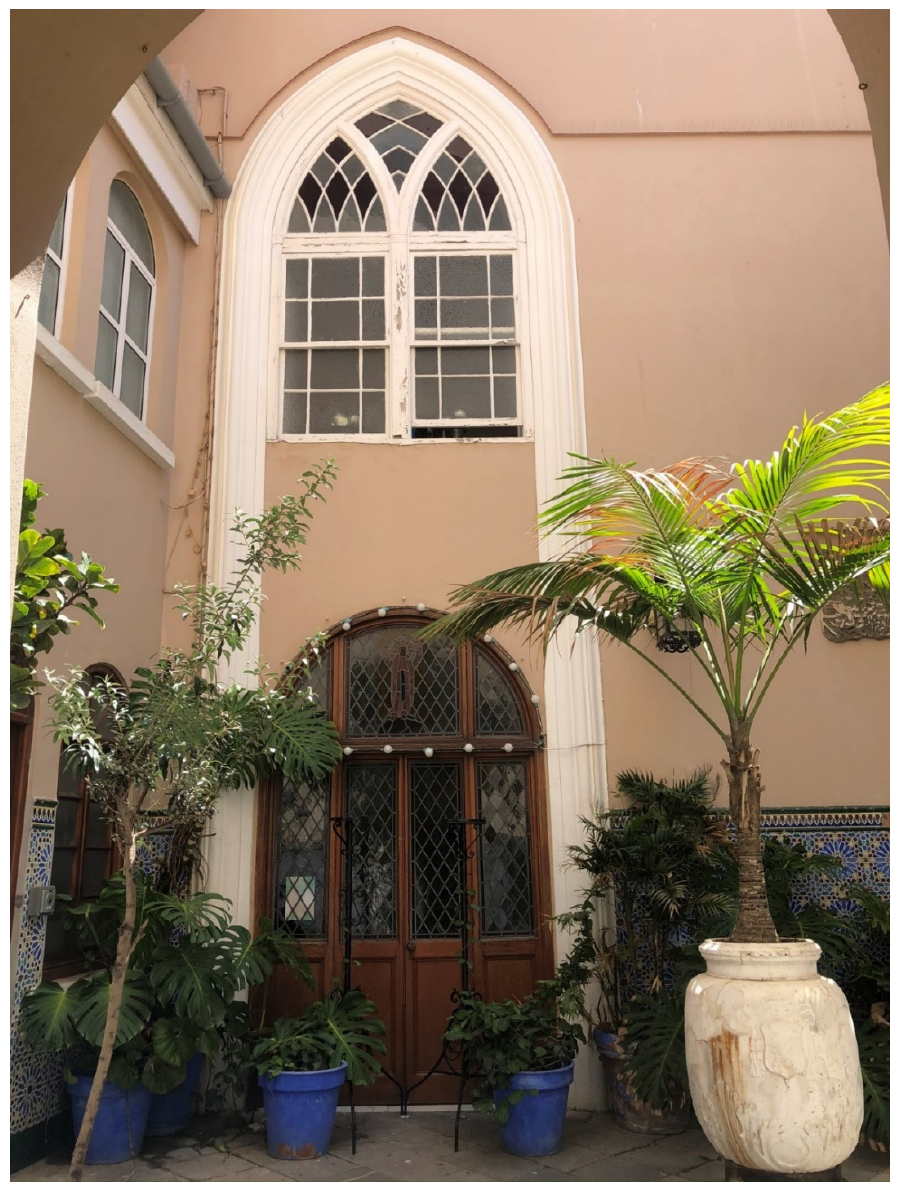
Figure 14. The Piña Chapel, today the Chapel of Our Lady of Lourdes in the Cathedral of Saint Mary the Crowned.